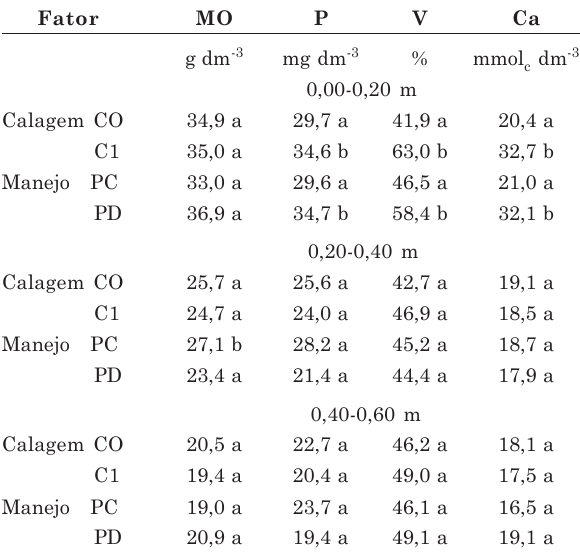
Quadro 2. Valores de matéria orgânica (MO), fósforo disponível (P), saturação por bases (V) e cálcio (Ca) por camada de solo sem calcário (C0) e com 2,0 t ha -1 de calcário (C1) nos tratamentos plantio direto (PD) e plantio convencional